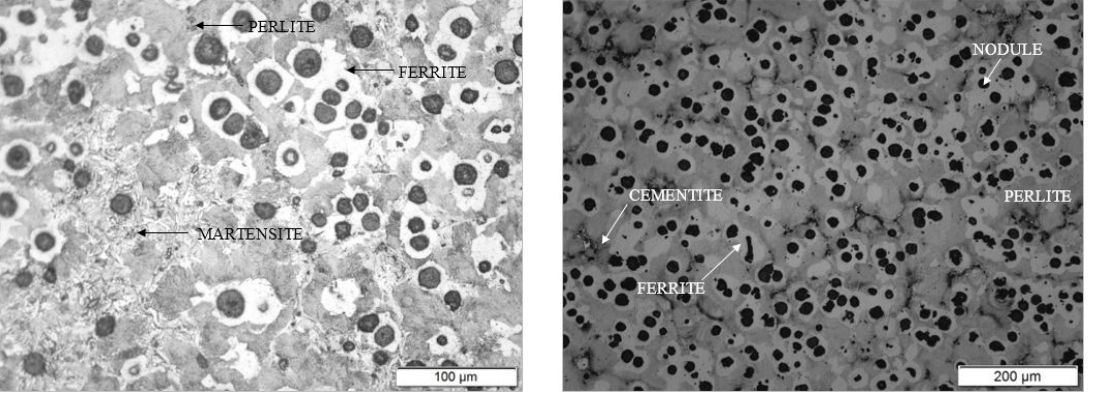
Figure 16. Matrix for Ni/Cu